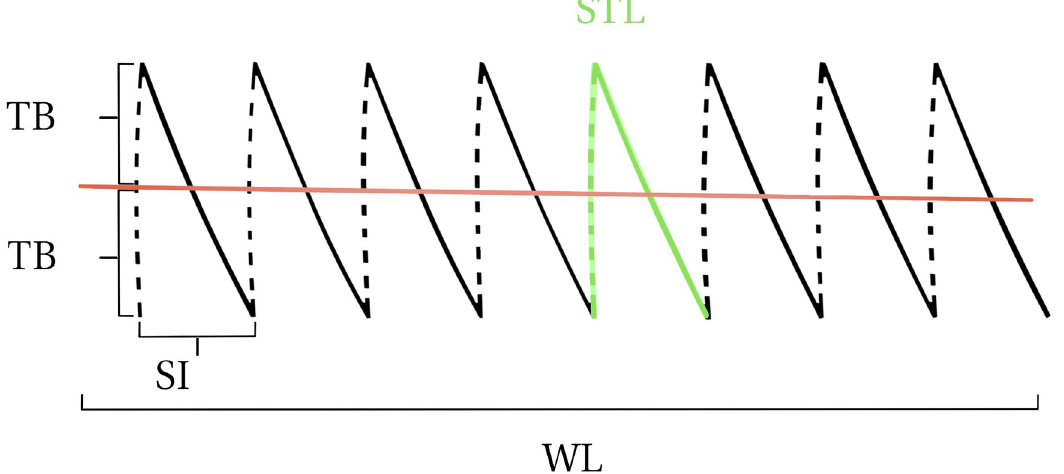
Fig 1. Abdominal midline laparotomy closure. TB = tissue bite, STL = stitch length, SI = stitch interval, WL = wound length.